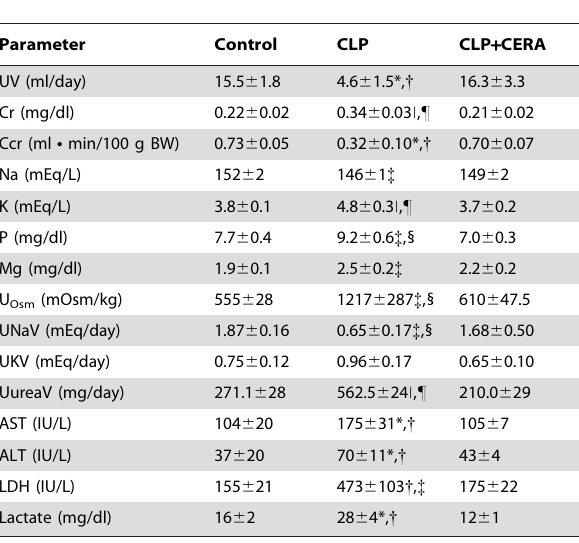
Table 1. Physiological